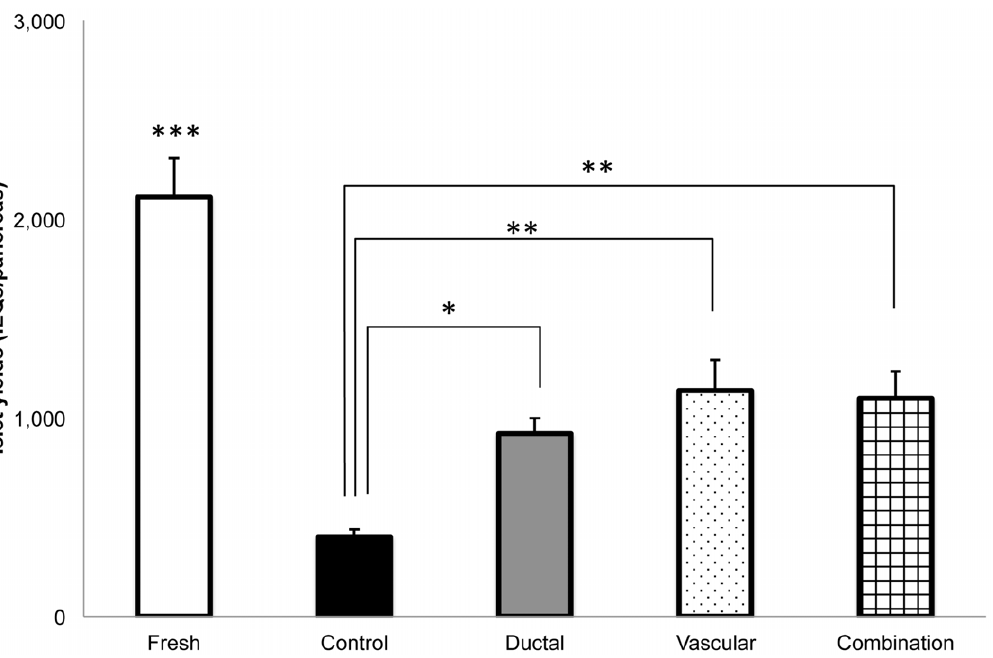
Figure 1. The effects of ductal injection and/or vascular perfusion on the islet yield (HBSS). In the HBSS model, the isolated islet yield was significantly increased in the ductal injection (gray bar: ductal group: n=9), vascular perfusion (dotted bar: vascular group: n=9), and ductal injection/vascular perfusion groups (squared bar: combination group: n=10) compared with that of the cold ischemia control group (black bar: control group: n=9). The islets isolated from pancreases with a negligible cold ischemia time (less than 10 min) served as the fresh control group (white bar: fresh group: n=7). The islet yield of the fresh group was significantly higher than that of the other groups. No significant differences were observed among the ductal, vascular, and combination groups. * P , 0.05, ** P , 0.005, *** P , 0.0001.